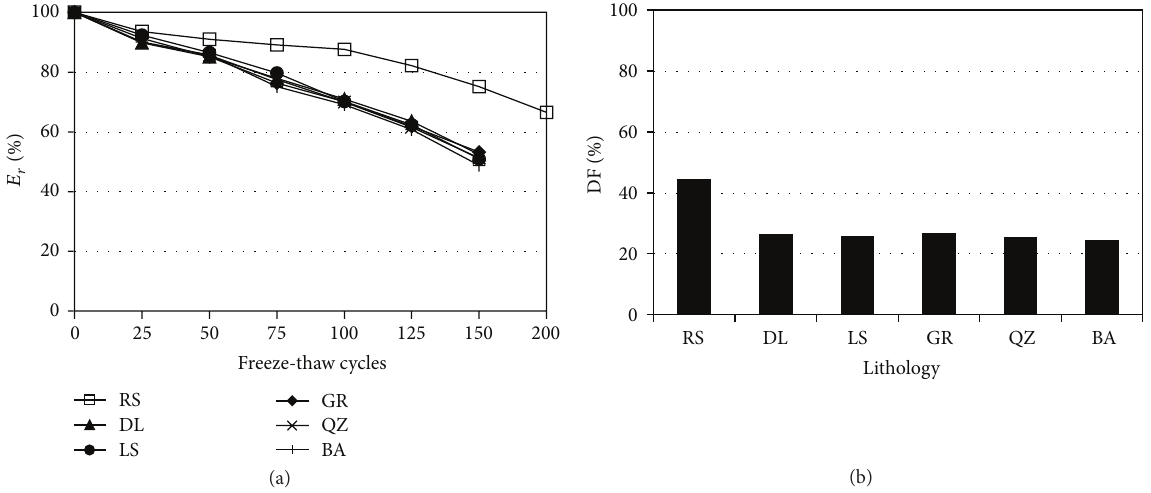
Figure 7: Effect of lithology on frost durability of C30 concrete: (a) 𝐸 𝑟 . (b) DF.